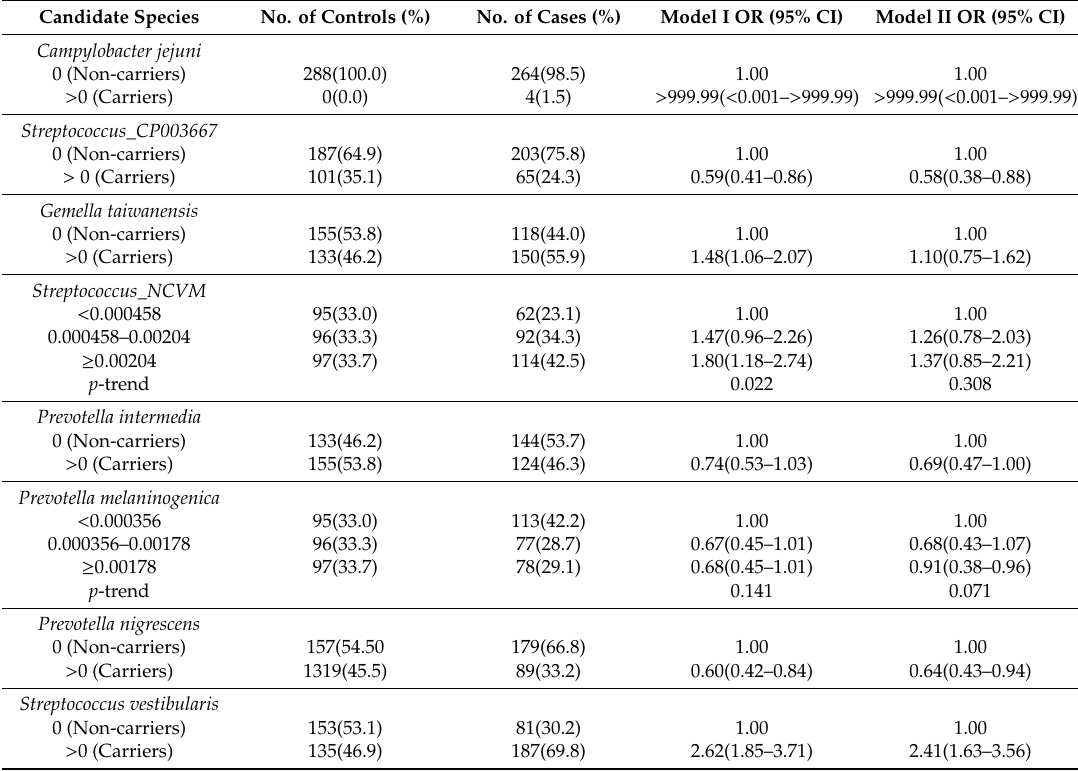
Table 2. Association between relative abundance of bacterial species and gastric cancer (GC)